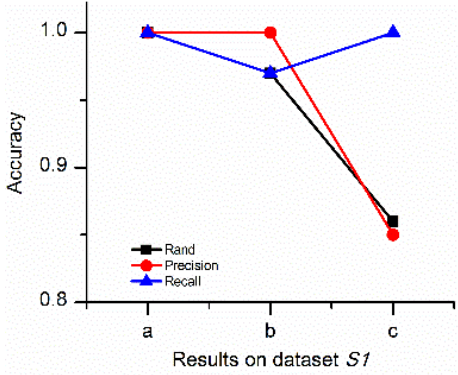
Figure 13. Clustering results on 𝑆1 with different values of 𝛽 : ( a ) optimized result; ( b ) result when 𝛽 is 1.00; and ( c ) result when 𝛽 is 2.00. ISPRS Int. J. Geo-Inf. 2016 , 5 , 205